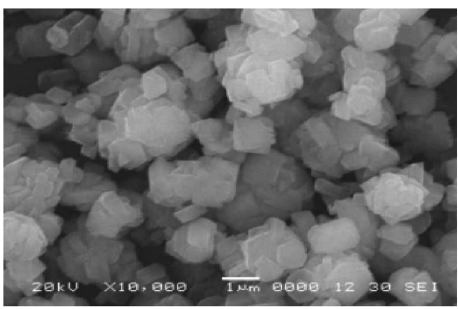
Figure 4: The structure of the Ce/Ag/ZnO nanocomposites magni fi ed 10,000 times under